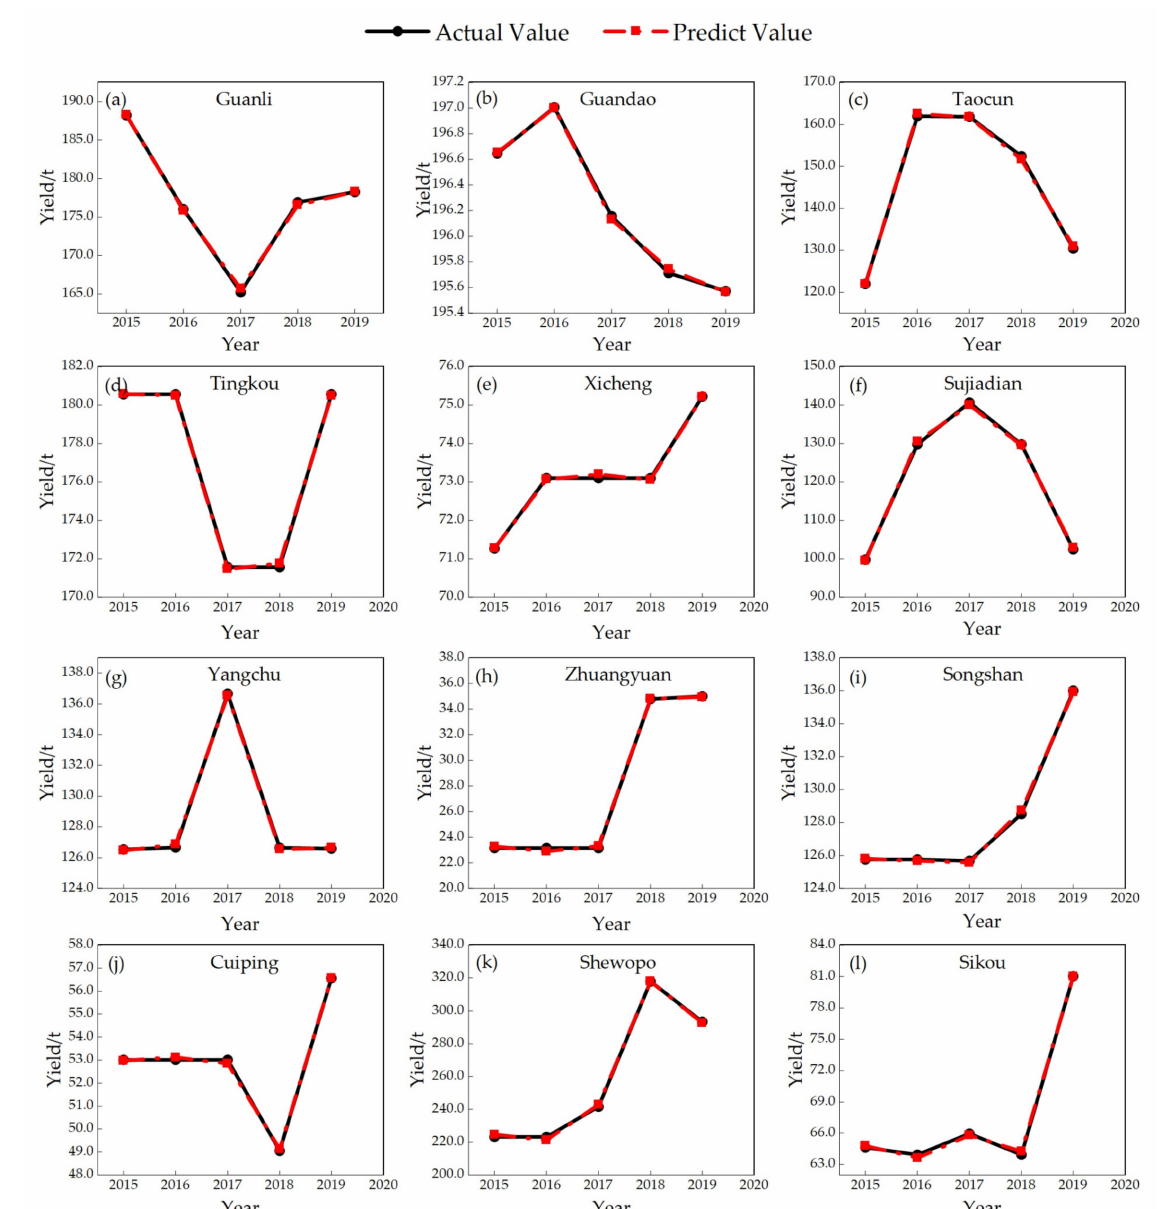
Figure 8. Training results of BP neural network model. ( a – l ) Predicted yield compared with the actual yield of model training results for each county in Qixia from 2015 to 2019. Actual yields are from statistical